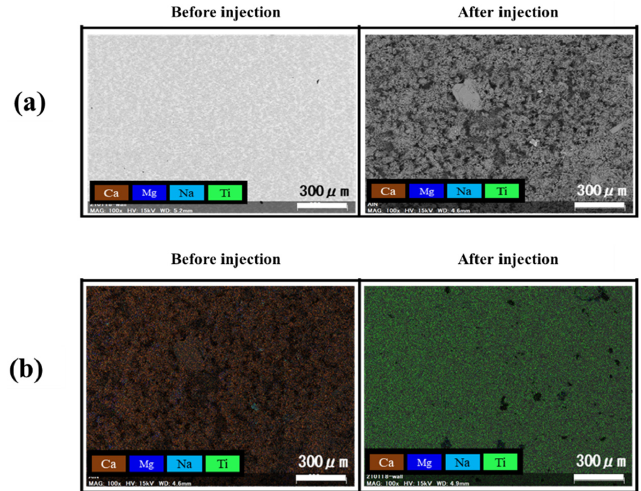
Figure 15. ( a ) is an SEM image before and after the tartar model deposition, ( b ) shows SEM images after deposition (tartar model) and after blasting with agar particles by WH-706. Brown in the figure represents Ca, blue represents Mg, light blue represents Na, and green represents Ti.